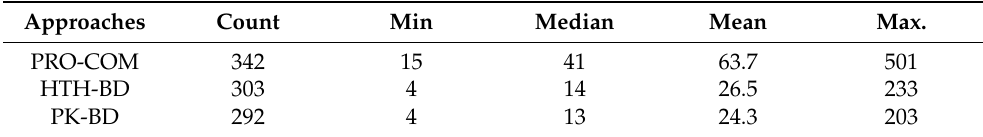
Table 16. Products per variety after eliminate first